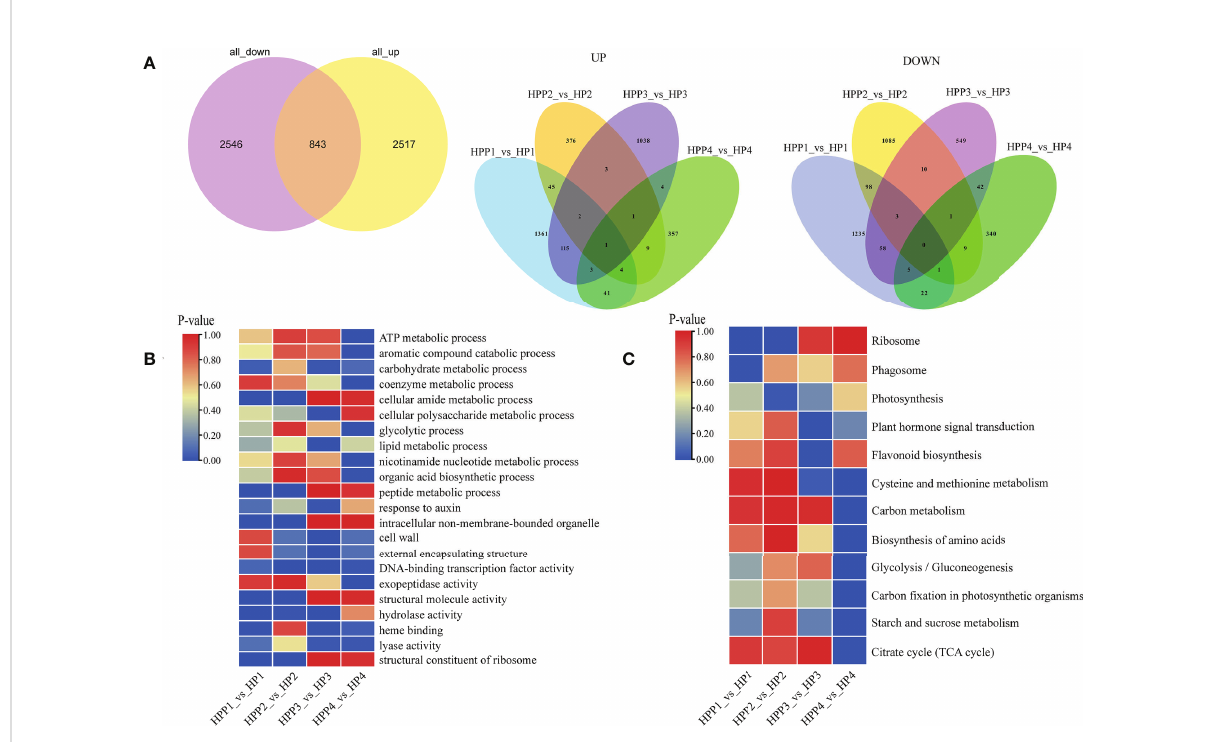
FIGURE 4 Analysis of functionally enriched differentially expressed genes (DEGs) between Harumi/Hongjv (HP) and Harumi/Ponkan/Hongjv (HPP) fruits. (A) Venn diagrams of all upregulated and downregulated genes between HP and HPP fruits. (B) Results of the Gene Ontology (GO) enrichment analysis of DEGs between HP and HPP fruits. (C) Results of the Kyoto Encyclopedia of Genes and Genomes (KEGG) pathway enrichment analysis of DEGs between HP and HPP fruits. HP1, HP2, HP3 and HP4 represent HP at 45, 90, 135, and 180 DAF, respectively; and HPP1, HPP2, HPP3 and HPP4 represent HPP at 45, 90, 135, and 180 DAF,